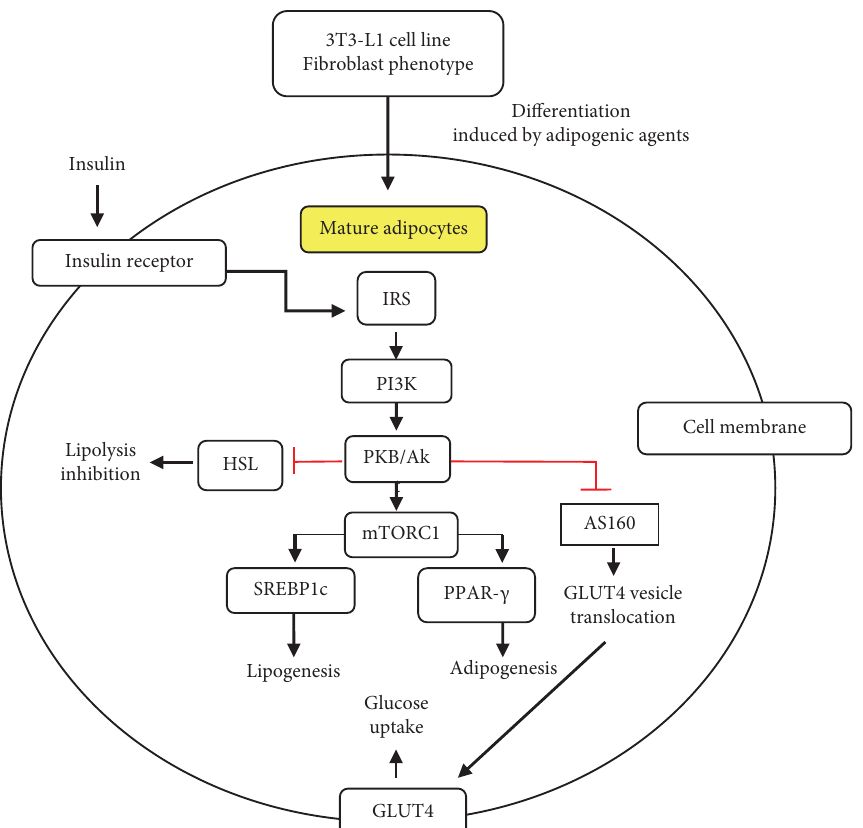
Figure 1: Te insulin signaling pathway in adipocytes (mature 3T3-L1 cell lines). Insulin binds to the insulin receptor (IR) and activates the downstream molecules, including IRS1/2, PI3-kinase (PI3K), and Akt. Te activated-Akt phosphorylates AS160 and inhibits its activation in stabilizing GLUT4, followed by GLUT4 translocation. It also enhances lipogenesis and adipogenesis via sterol regulatory element binding protein 1c (SREBP-1c) and PPAR c related to mTORC1 activation. Moreover, the activated- Akt inhibits lipolysis by suppressing hormone- specifc lipase